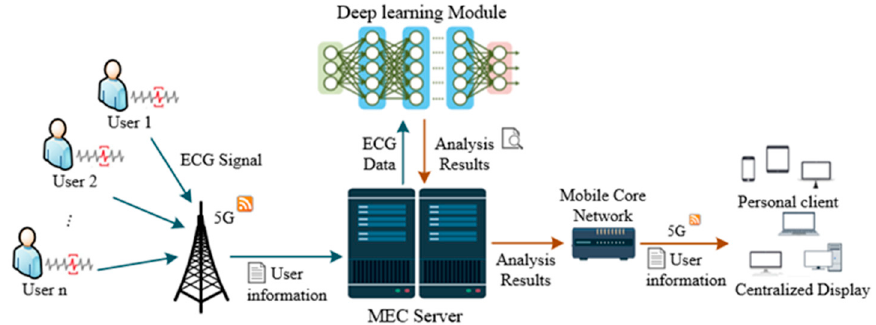
Figure 2. Dataflow over the system model.